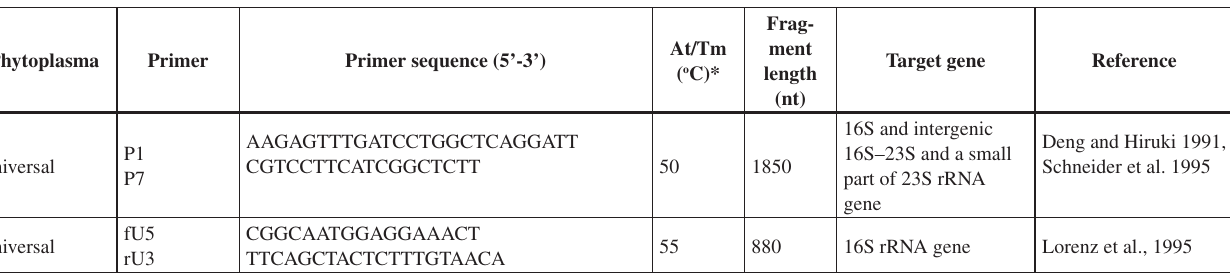
Table 3. Phytoplasma specific